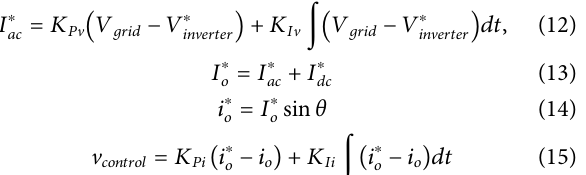
Therefore, the output current of the single-phase inverter can